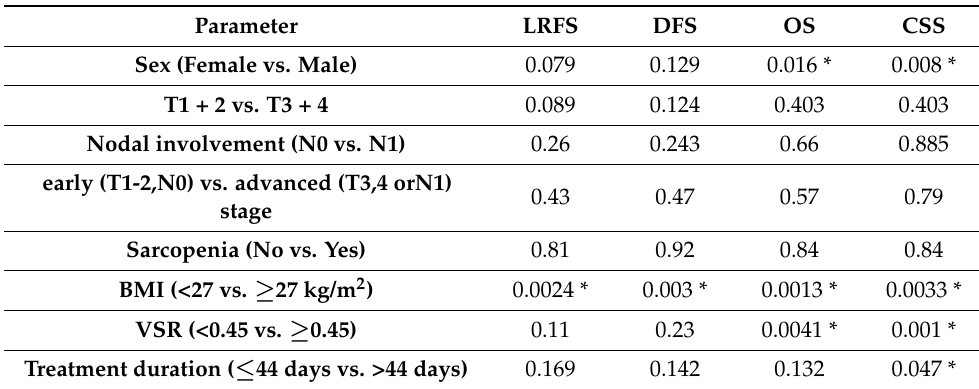
Table 2. BMI: body mass index; VSR: visceral-to-subcutaneous fat ratio univariate analysis using the log-rank test. * p -value < 0.05: